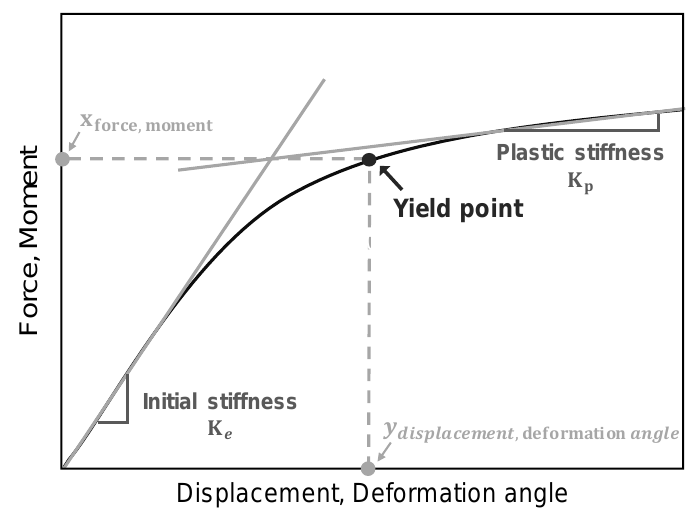
Figure 7. Calculation of the yield point using the tangent intersection (TI) method.